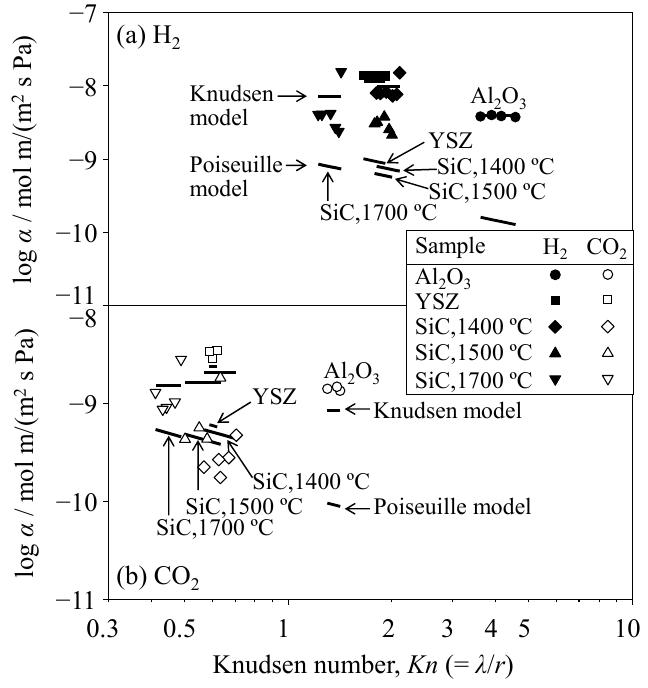
Figure 9. Permeability coefficients of ( a ) H 2 gas and ( b ) CO 2 gas in Al 2 O 3 , YSZ, and SiC porous ceramics against the pressure gradient above the ∆ P c / L value as a function of the Knudsen number.